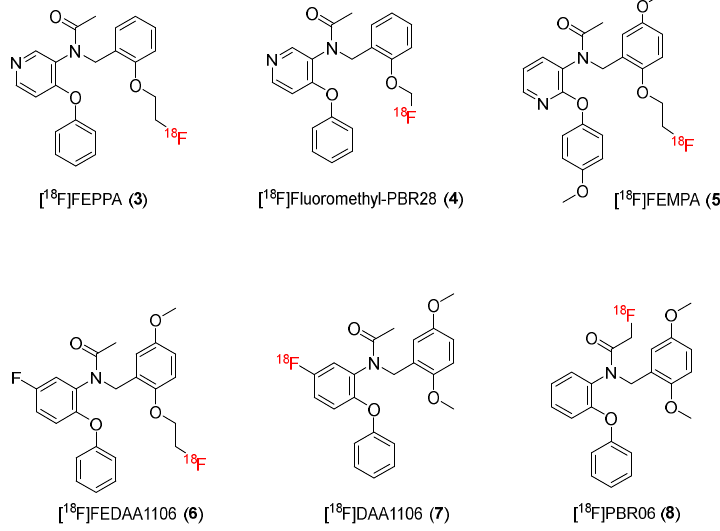
Figure 2. Structures of TSPO ligands containing